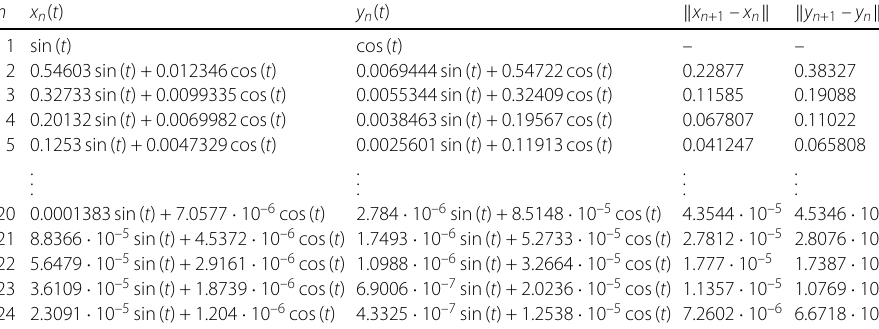
Table 4 Computational results of Case 3 for Example